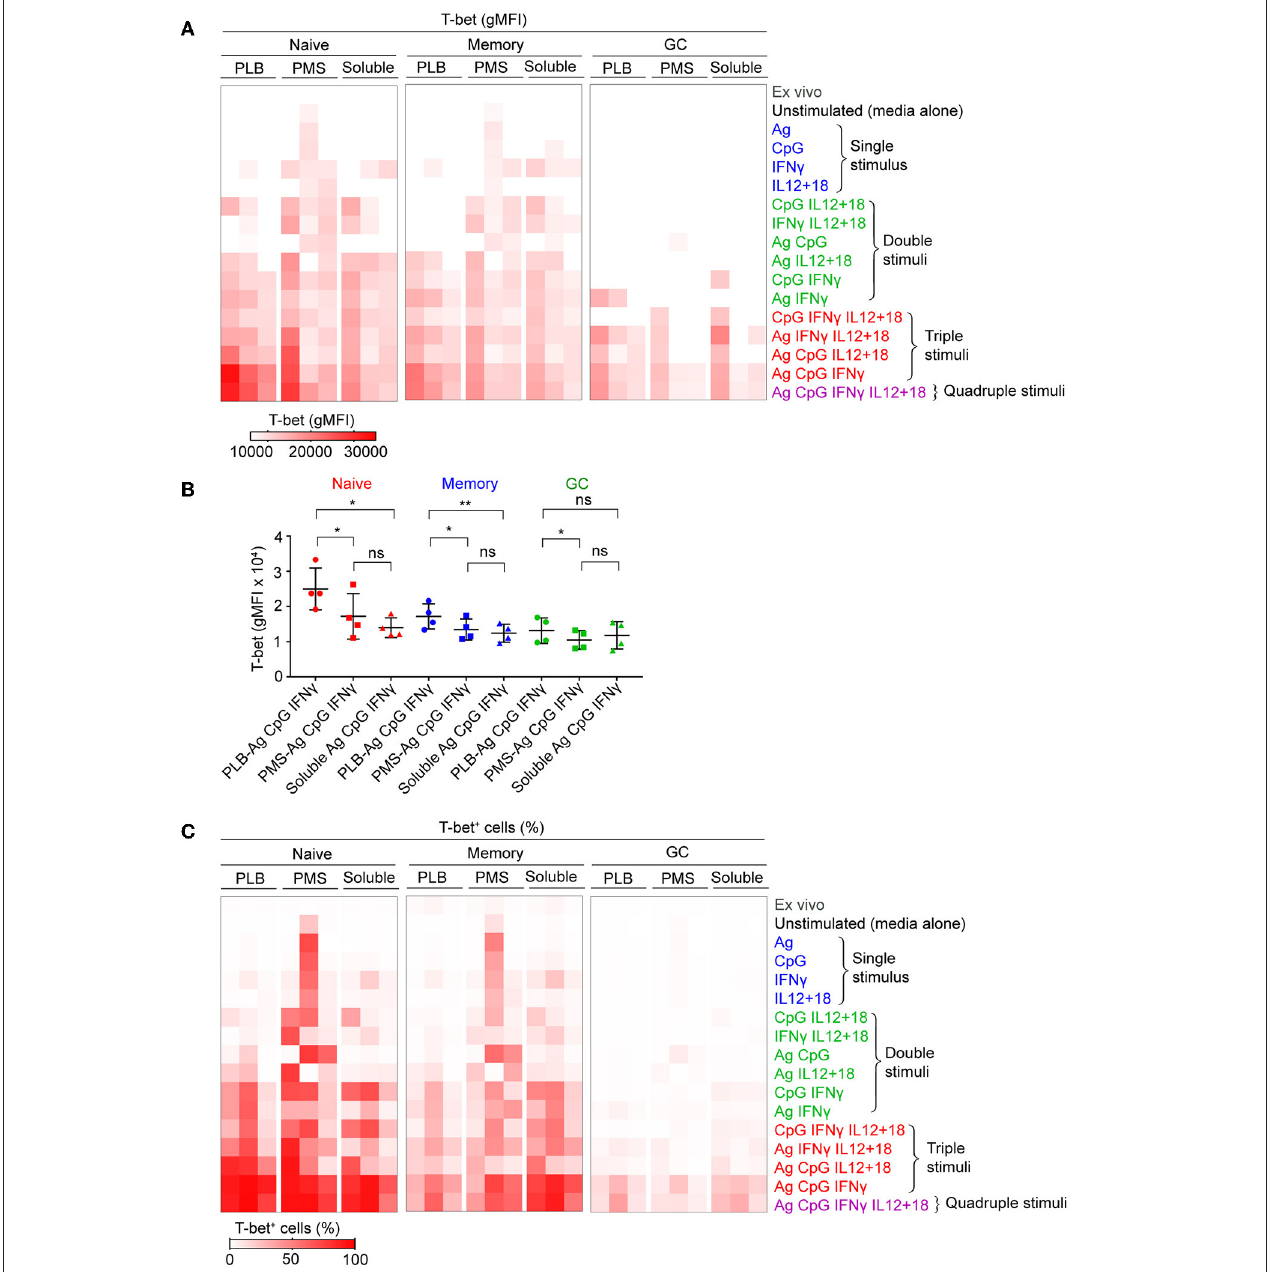
FIGURE 1 | Tonsil B cells express T-bet upon BCR, TLR9, and IFN- γ stimulation in vitro. Tonsil B cells were cultured in vitro for 40h with combination of antigen, either soluble or presented on a planar lipid bilayer (PLB) or plasma membrane sheet (PMS), CpG, IFN- γ , or IL-12 + IL-18. T-bet expression in naïve (IgD + CD10 − ), memory (IgD − CD10 − ), and GC (IgD − CD10 + ) B cells was analyzed by flow cytometry. (A) Heat map indicating T-bet expression (gMFI) by naïve, memory, and GC B cells of the three individuals (columns) from three representative experiments. The stimulation conditions are as indicated to the right of heat map and are grouped into single, double, triple, and quadruple stimuli. The columns are subgrouped according to the mode of antigen presentation either attached to PLB or PMS or soluble. The gMFI is calculated for conditions in which a minimum of 5% of the cells were T-bet + . (B) Comparison of T-bet expression (gMFI) by naïve, memory, and GC B cells stimulated in vitro with antigen either attached to PLB or PMS or soluble, in the presence of CpG and IFN- γ ( n = 4). Data for T-bet expression (gMFI) by naïve, memory, and GC B cells stimulated in vitro on all stimulation conditions is provided in Supplementary Table 1 . Data were analyzed using one-way analysis of variance (ANOVA) with Tukey’s adjustment. * P < 0.05; ** P < 0.01; ns, not significant. (C) Heat map indicating the percent of T-bet + cells for each of the conditions in (A) .